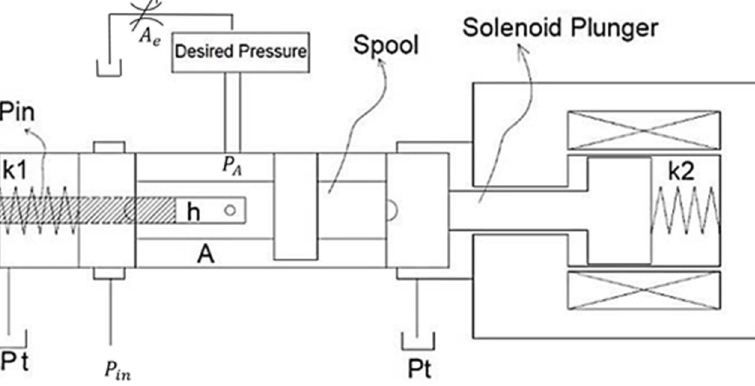
Figure 3. Simplified schematic of the pin-type spool actuator connected to an inlet pressure, P in , and an outlet orifice, Ae .